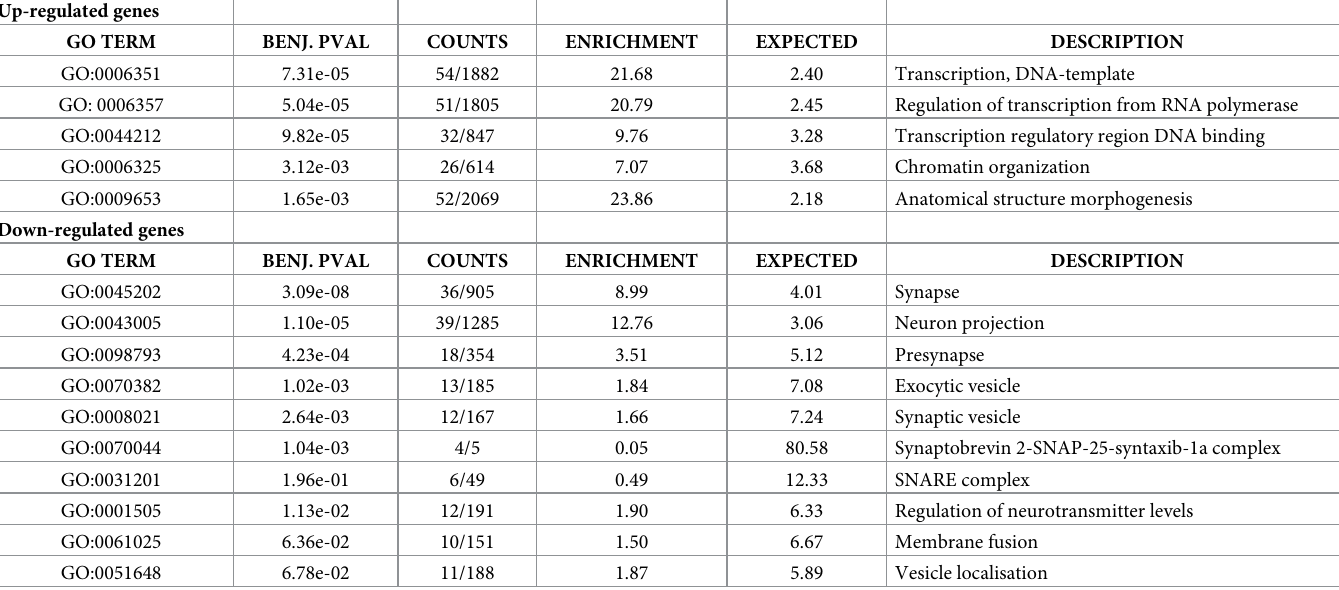
Table 1. Gene ontology enrichment derived from up- and down-regulated genes in the Dyrk1a C/C